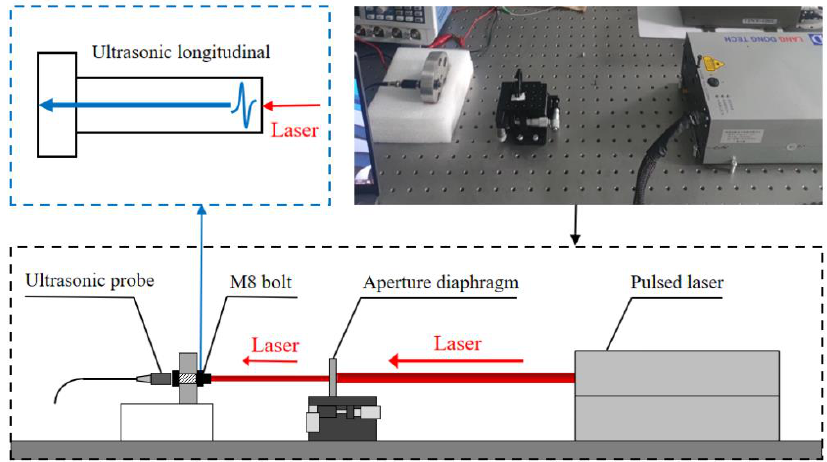
Figure 3. Schematic diagram and experimental setup of the laser ultrasonic excitation unit.